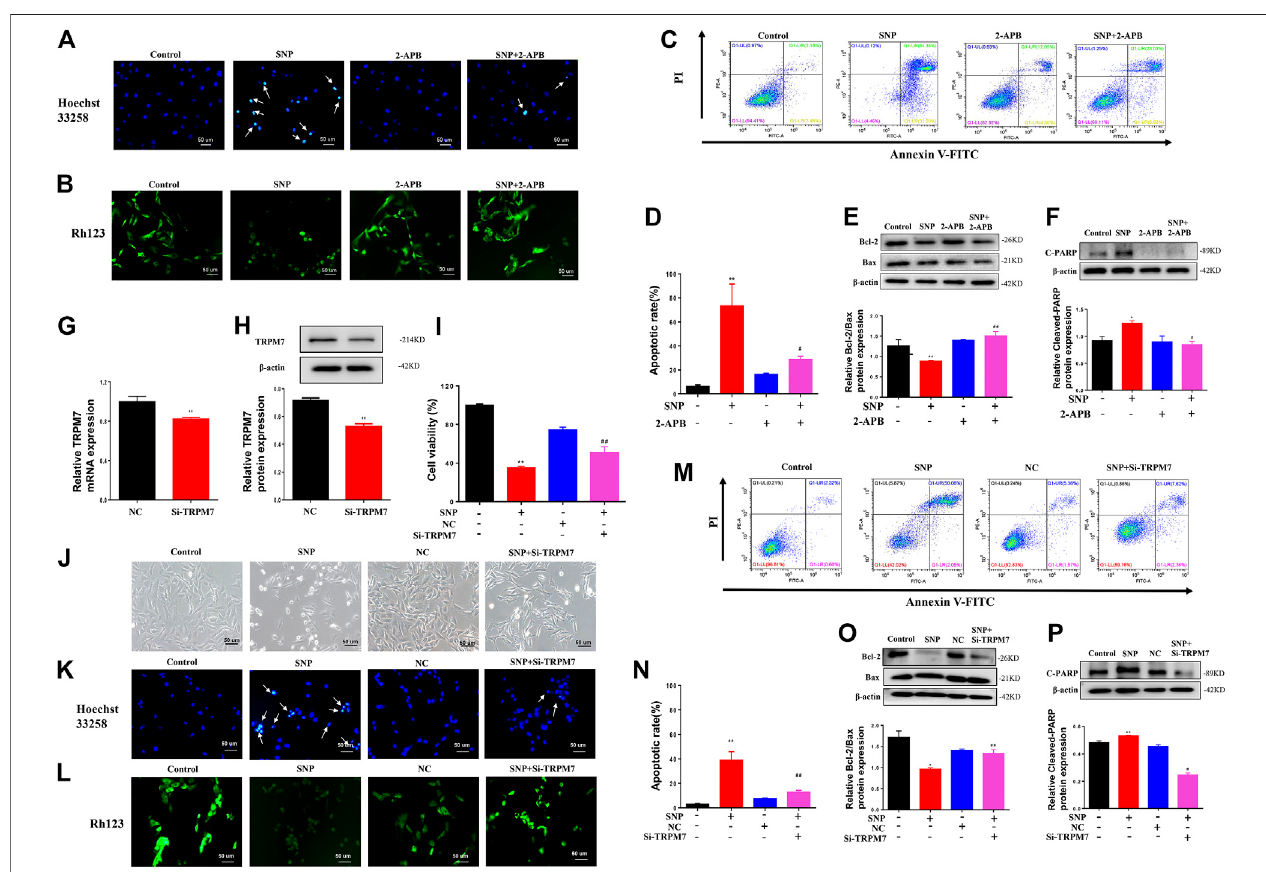
FIGURE2| 2-APBorSi-TRPM7reducesSNP-inducedchondrocyteapoptosis (A) Hoechst33,258stainof2-APBonSNP-inducedchondrocytechromatinofthe nucleus ( n (cid:2) 3) (B) Rh123 satin of 2-APB on SNP-induced mitochondrial membrane potential ( n (cid:2) 3) (C) Annexin V-FITC and PI satin of 2-APB on SNP-induced chondrocyteapoptosis( n (cid:2) 3) (D) Quantitativeanalysisofchondrocyteapoptosisrate( n (cid:2) 3) (E) Westernblotanalysisof2-APBontheBcl-2/Baxratio( n (cid:2) 3) (F) Western blotanalysisof2-APBoncleaved PARPproteinexpression( n (cid:2) 3) (G) qRT-PCRanalysisofTRPM7mRNAexpressioninchondrocytes treatedwithSi-TRPM7( n (cid:2) 3) (H) Western blot analysis of TRPM7 protein expression in chondrocytes treated with Si-TRPM7 ( n (cid:2) 3) (I) MTT analysis of Si-TRPM7 on cell viability of SNP-treated chondrocytes ( n (cid:2) 6) (J) Morphology of Si-TRPM7 on SNP-induced chondrocytes ( n (cid:2) 3) (K) Hoechst 33,258 stain of Si-TRPM7 on SNP-induced chondrocyte chromatinofthenucleus( n (cid:2) 3) (L) Rh123satinofSi-TRPM7onSNP-inducedmitochondrialmembranepotential( n (cid:2) 3) (M) AnnexinV-FITCandPIsatinofSi-TRPM7on SNP-inducedchondrocyteapoptosis( n (cid:2) 3) (N) Quantitativeanalysisofchondrocyteapoptosisrate( n (cid:2) 3) (O) WesternblotanalysisofSi-TRPM7onBcl-2/Baxratio( n (cid:2) 3) (P) Western blot analysis of Si-TRPM7 on cleaved PARPprotein expression ( n (cid:2) 3). Chondrocytes were seeded in 6-well plates cultured for 24 h, then treated with 2- APB(100 μ M)andSNP(0.5 mM)for12 h,orchondrocyteswereseededin6-wellplates,culturedfor12 h,aftertransfectedwithSi-TRPM7for4 handculturedfor24 h, thenSNP(0.5 mM)wasaddedandincubatedfor12 h.Valuesarepresentedasmean ± SEM.*P < 0.05, ** p < 0.01,comparedwithcontrolgroup; # p < 0.05, ## p < 0.01, compared with SNP